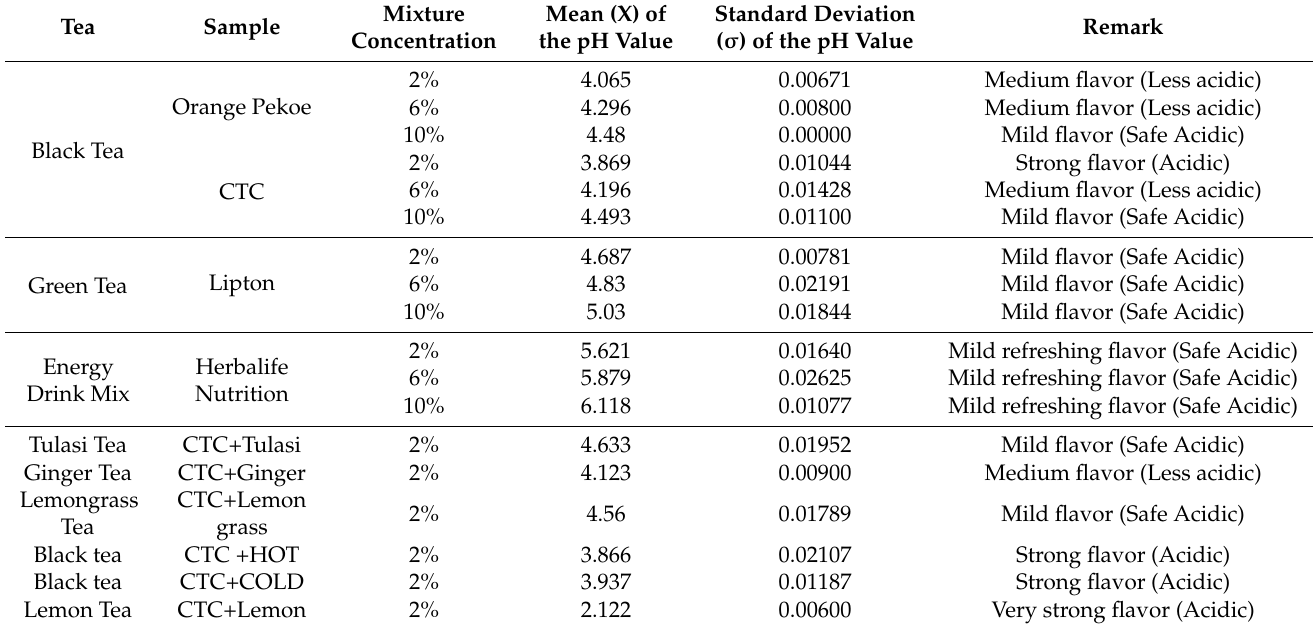
Table 8. Comparative analysis of the tea samples with different mixture proportions for their pH